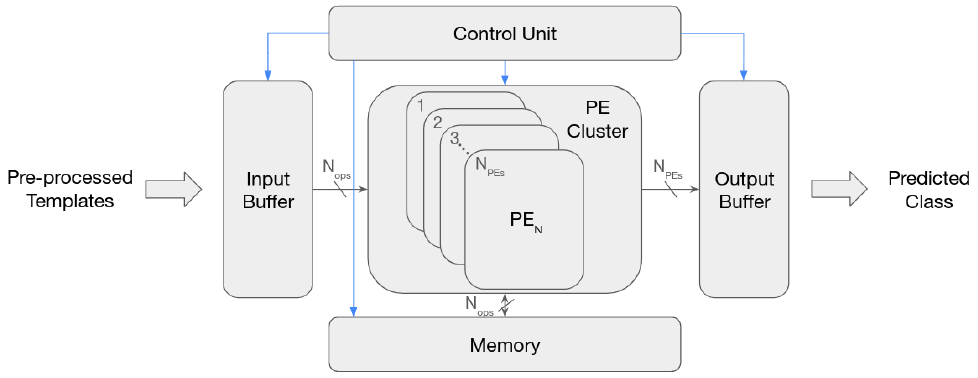
Figure 3. ECG-ID-BNet accelerator high-level architecture. The blue arrows represent the control signals, while the black arrows depict the datapath. N ops denoted the number of operations each PE processes at a time and N PEs denote the number of processing